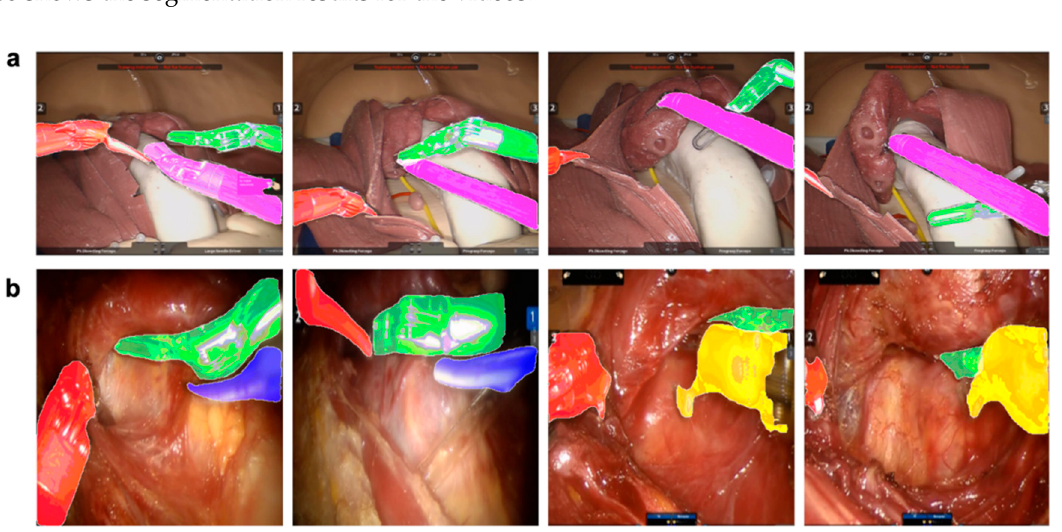
Figure 3. Qualitative results of the instance segmentation framework. Recognition of occlusion between surgical instruments located close together or overlapping (red: bipolar ( i ); pink: bipolar ( ii ); green: forceps; blue: harmonic; yellow: cautery hook). ( a ) Application of sample results to the bilateral axillo-breast approach (BABA) training model. ( b ) Application of sample results to patients.